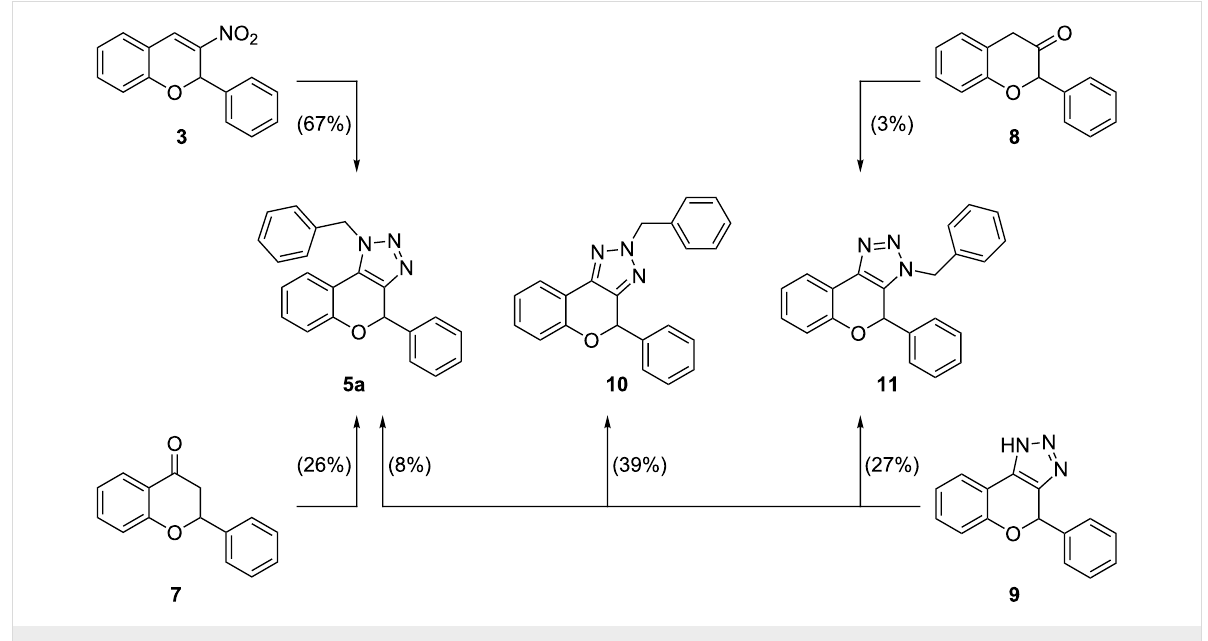
Scheme 2: Reaction pathways leading to the different